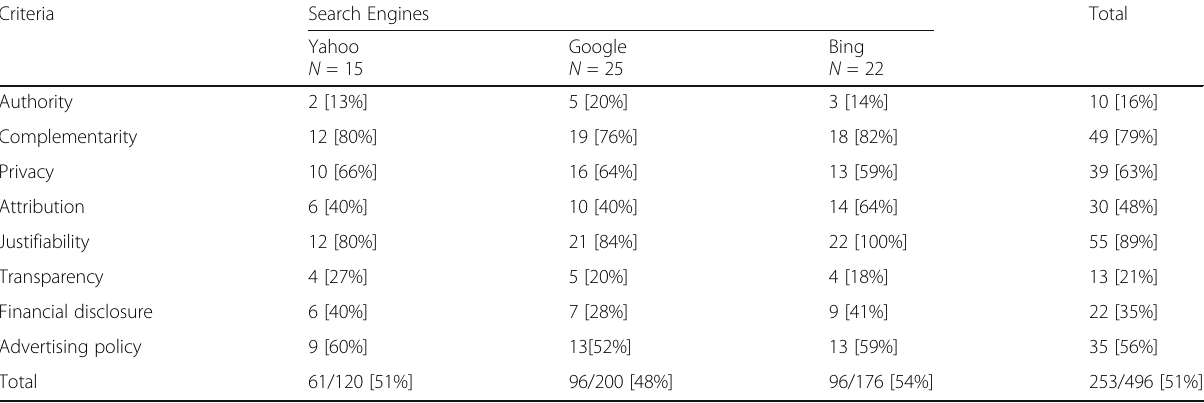
Table 2 Total number and Percentage of websites which are in compliance with each criterion of HONcode